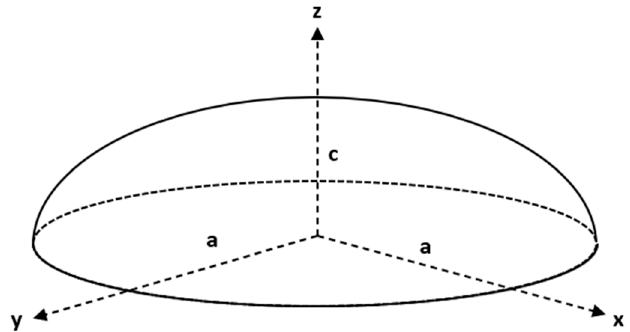
Figure 5. Schematic representation of the average shape of the bubbles during their rise through the